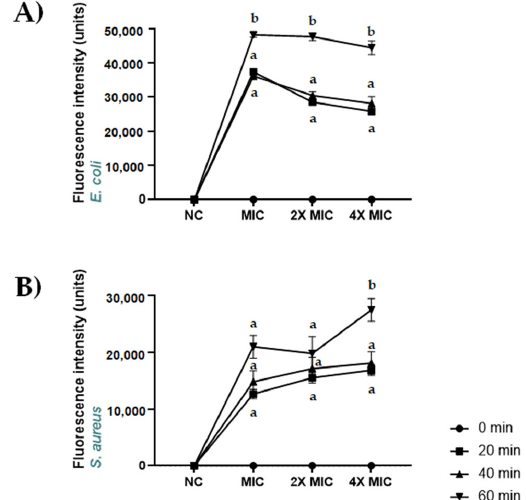
at a concentration equal to the MIC for E. coli and 4X MIC for S. aureus .